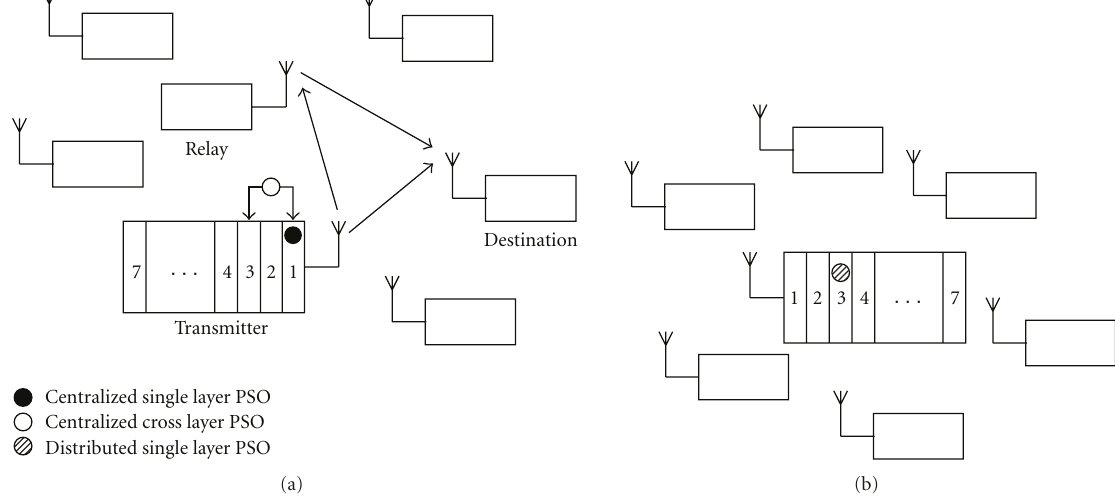
Figure 4: Utilization of generalized PSO in adaptive MCCC: (a) centralized single layer and cross layer PSO and (b) distributed single layer